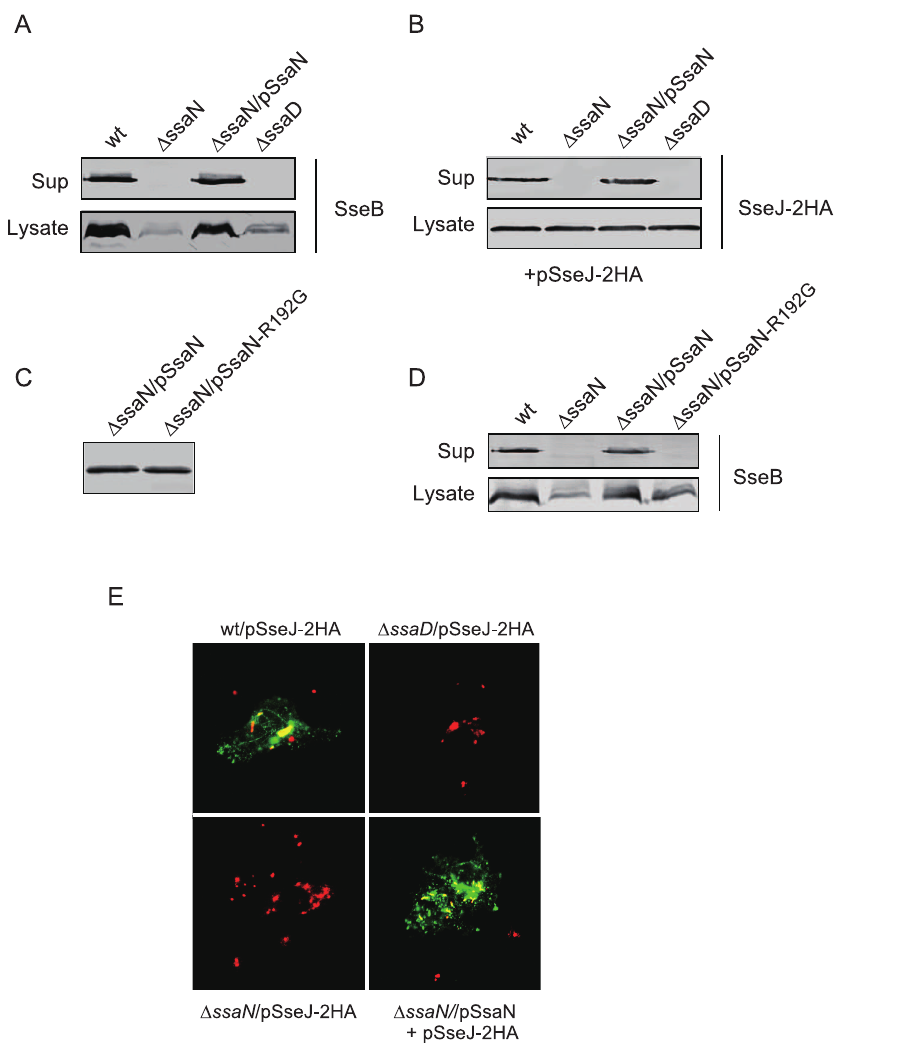
Figure 2. SsaN is required for Salmonella T3SS-2 dependent secretion. ( A ) Salmonella wild-type, D ssaN mutant, D ssaN mutant complemented with cloned ssaN , and ssaD mutant strains were grown in LPM medium (pH 5.8). Protein samples from equal numbers of bacteria were analyzed by Western blotting using an anti-SseB antibody for the secreted protein fraction (Sup) and whole cell lysates (Lysate). ( B ) Salmonella wild-type and mutant strains that harbored pSseJ-2HA plasmid were grown in LPM medium (pH 5.8). Protein samples from equal numbers of bacteria were subjected to Western blot analysis to detect SeeJ-2HA and SseB in secreted protein fractions (Sup) and in whole cell lysates (Lysate). ( C ) Salmonella wild-type, D ssaN mutant, D ssaN mutant complemented with cloned ssaN , and D ssaN mutant complemented with point mutated ssaN R192G strains were grown in LPM medium (pH 5.8). Protein samples from equal numbers of bacteria were analyzed by Western blotting with an anti-SseB antibody for the secreted protein fraction (Sup) and whole cell lysates (Lysate). ( D ) Confocal immunofluorescence analysis of HeLa cells infected with Salmonella strains that expressed SseJ-2HA. Infected cells were fixed at 8 h after infection. Bacteria were labeled with a rabbit anti- Salmonella LPS O4 antibody ( red ), and a mouse anti-HA antibody was used to detect HA-fusion proteins ( green ). All these experiments were repeated independently three times with similar results. Representative images are shown.